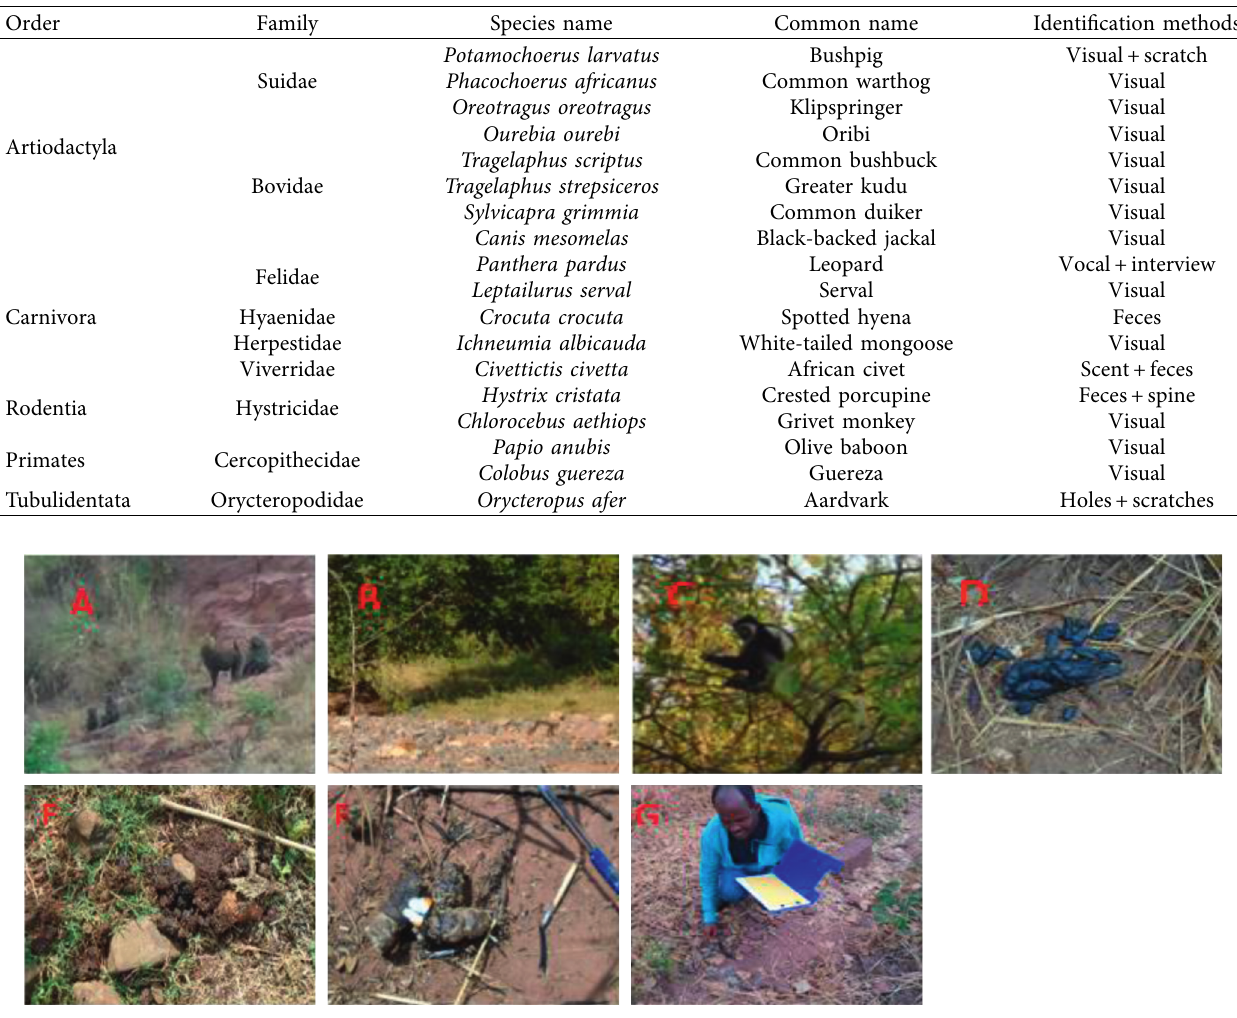
Table 1: List of species recorded in